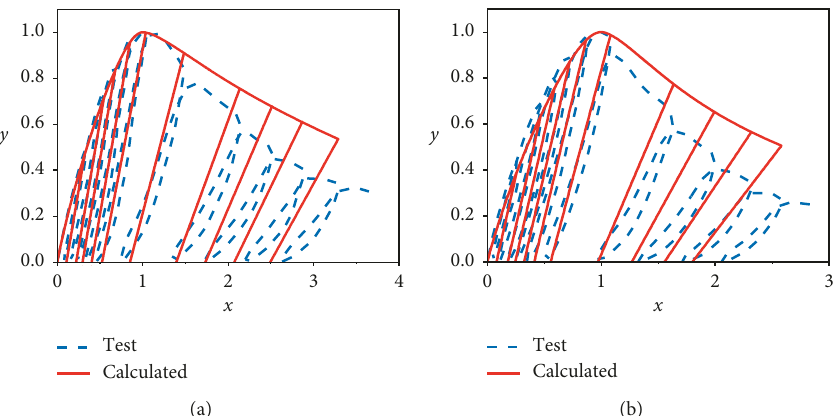
Figure 18: Verification of the proposed model in the case of cyclic loading using the other test results [34]. (a) RAC-50 ( r � 50%). (b) RAC- 100 ( r �